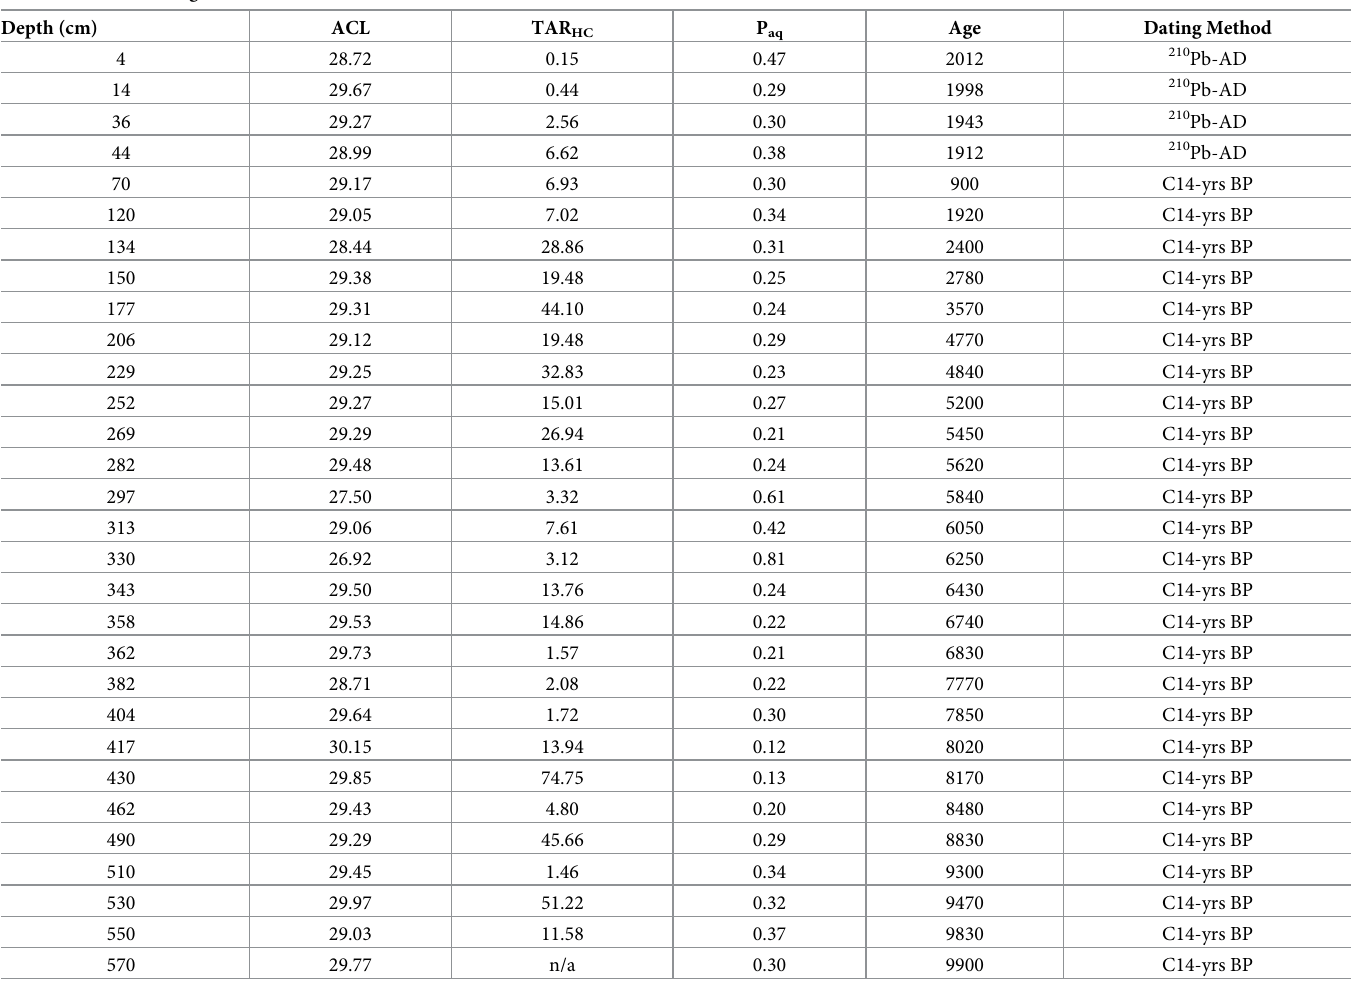
Table 2. Proxies for organic matter